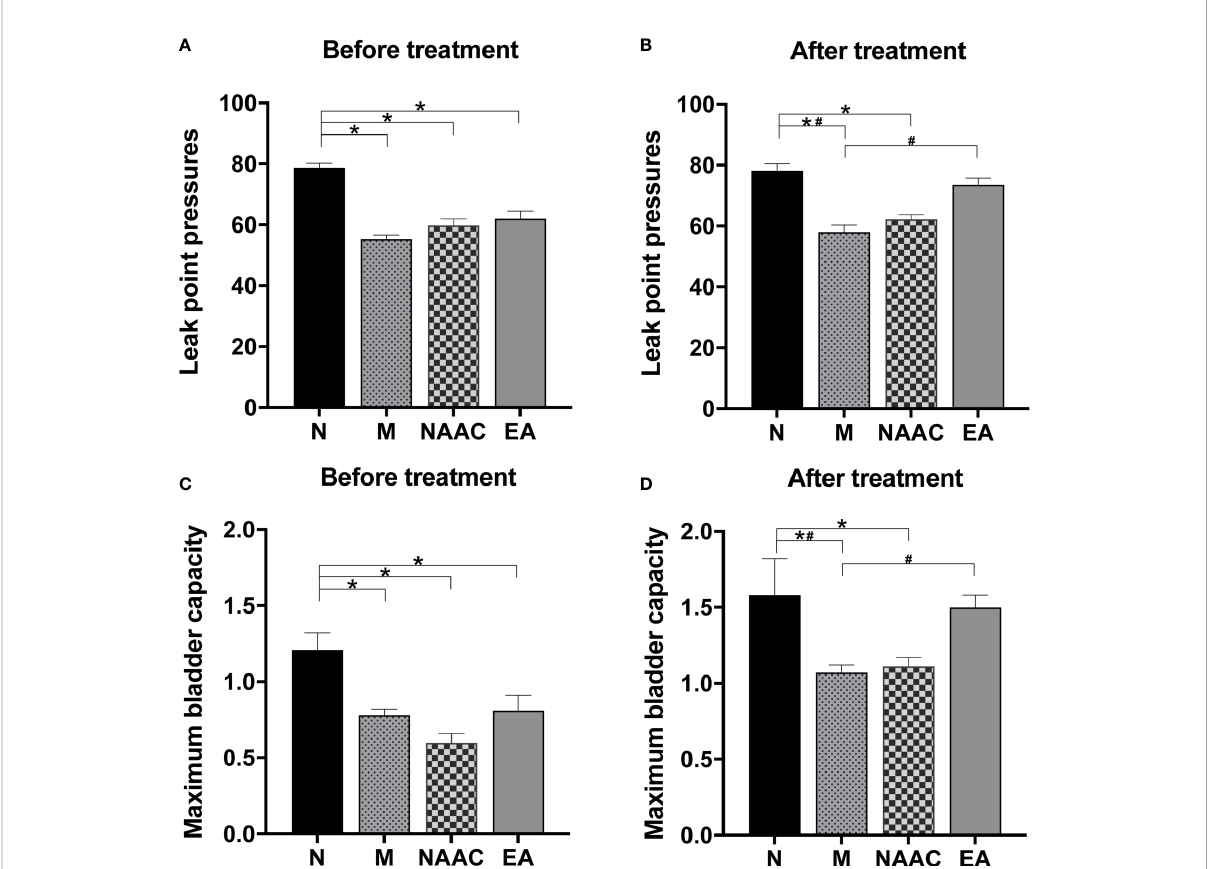
FIGURE 1 The effects of EA on LPP (A, B) and MBC (C, D) in rats with SUI (N=6, M=5, NAAC=6, EA=6). (A) The LPP before treatment was analyzed via one- way analysis of variance (ANOVA) (F (3,19) = 27.702, P =0.001 <0.05), followed by pairwise comparison using the least signi fi cant difference (LSD) test. (B) The LPP after treatment was analyzed via ANOVA (F (3,19) = 19.551, P =0.001 <0.05), followed by pairwise comparison using the LSD test. (C) The MBC before treatment was analyzed via ANOVA (F (3,19) = 8.515, P =0.001 <0.05), followed by pairwise comparison using the LSD test. (D) The MBC after treatment was analyzed via ANOVA (F (3,19) = 3.455, P =0.037 <0.05), followed by pairwise comparison using the LSD test. * P < 0.05 compared with the N group; # P < 0.05 compared with the M